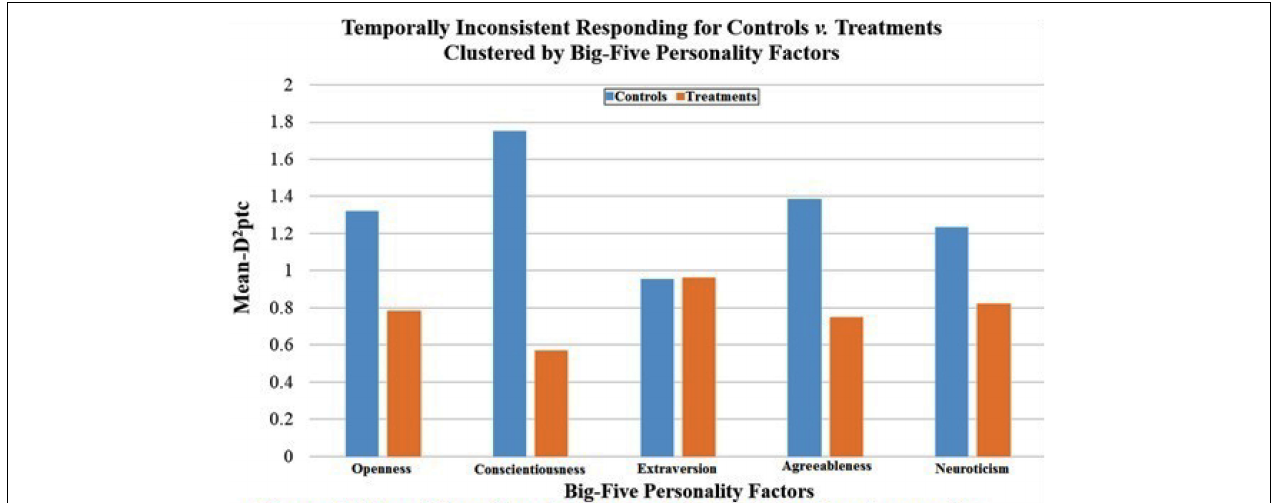
FIGURE 2 | Mean- D 2 Ptc values indexing experimental effects on temporally inconsistent responding across the five-factor model of personality, N =